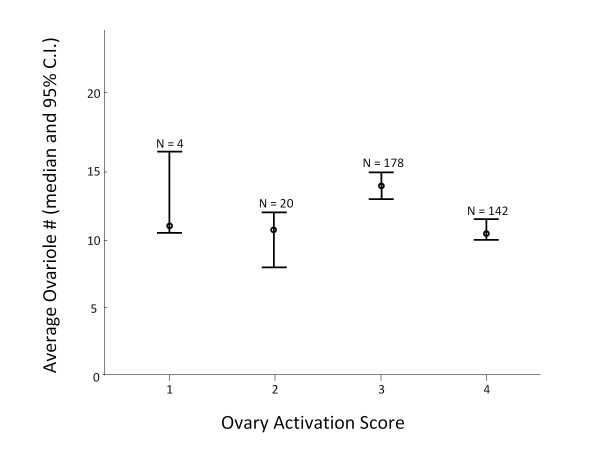
The relationship between ovary size and degree of ovary activation under queenless conditions in Africanized backcross workers that are characterized by large ovaries. Almost all workers have developed their ovaries to some extent. The workers with the largest ovaries only had an activation score of three in contrast to some workers with smaller ovaries that contained fully developed eggs.